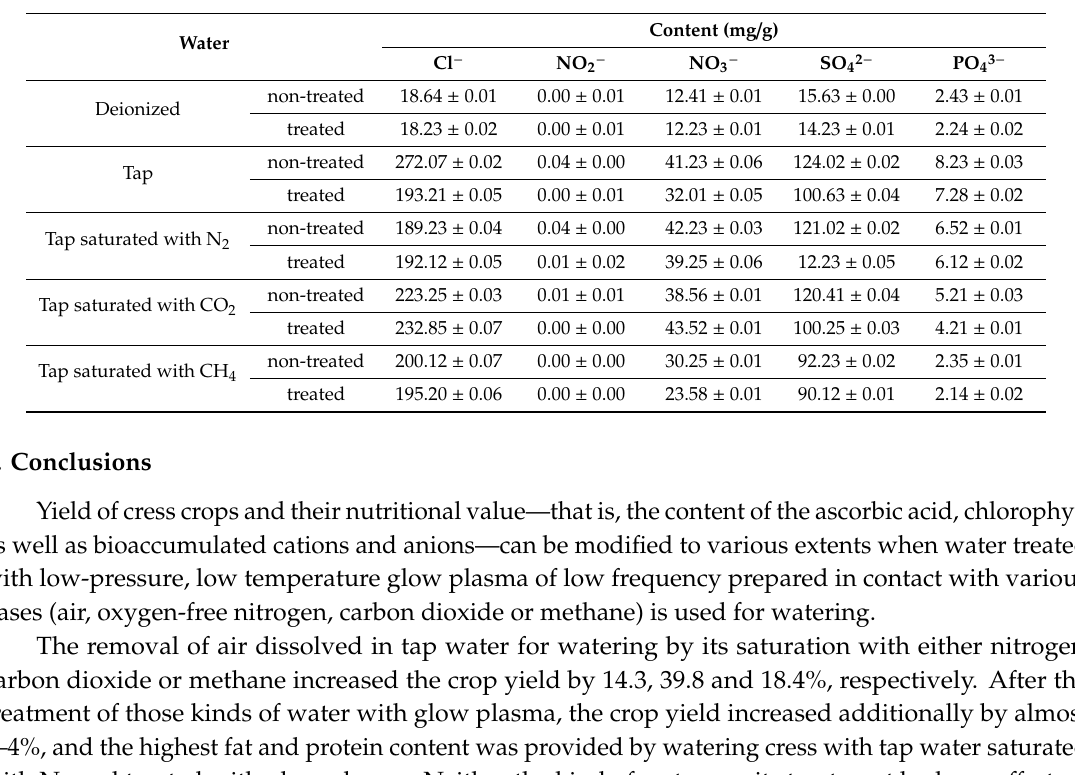
Table 5. Bioaccumulation of anions in cress watered with particular kinds of